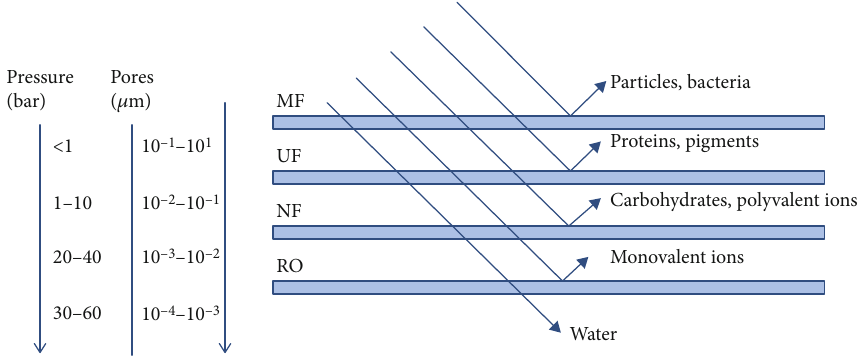
Figure 1: Classi fi cation of pressure-driven membrane